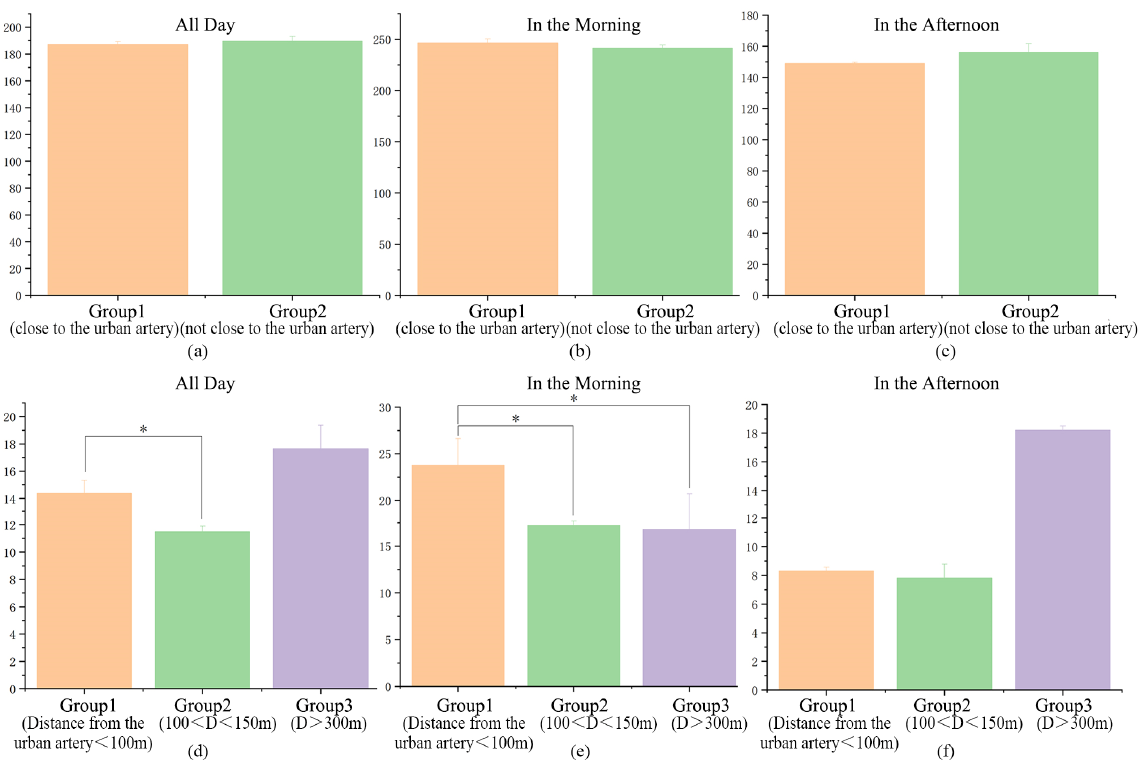
Figure 4. Variance analysis of the spatial distribution of PM2.5 concentrations (( a – c ): PM2.5 concentration; ( d – f ): difference value). * p < 0.05.